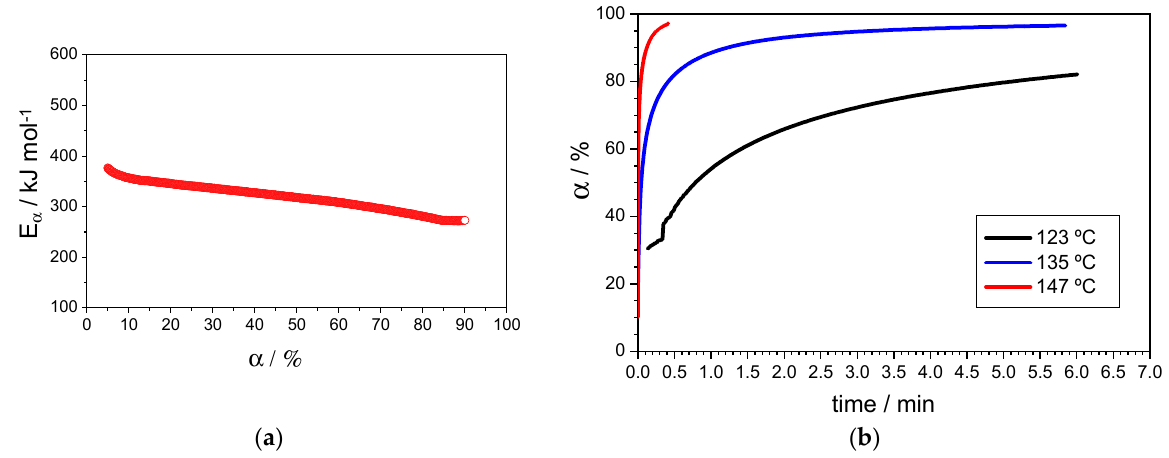
Figure 12. Evolution of the activation energy, E α , with the conversion degree, α ( a ). Calculated isoconversion curves at three temperatures ( b ).